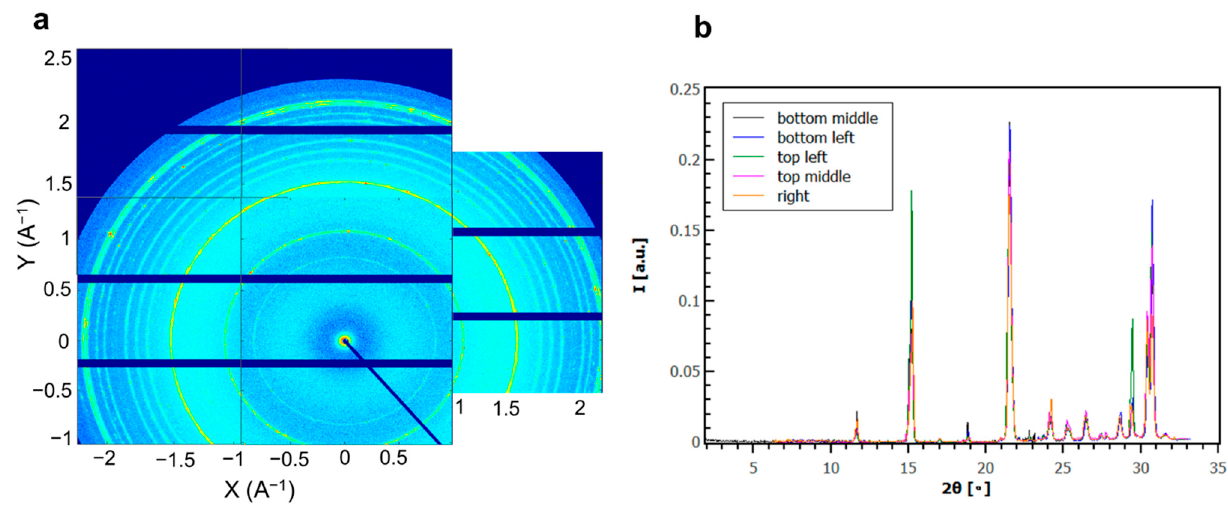
Figure 2. ( a ) Wide angle scattering data for grounded CsPbBr 3 set together from several detector pictures. The blue horizontal lines are non-sensitive positions of the Pilatus3 R 300K detector; ( b ) I(q) vs. 2q for the detector pictures depicted in ( a ).